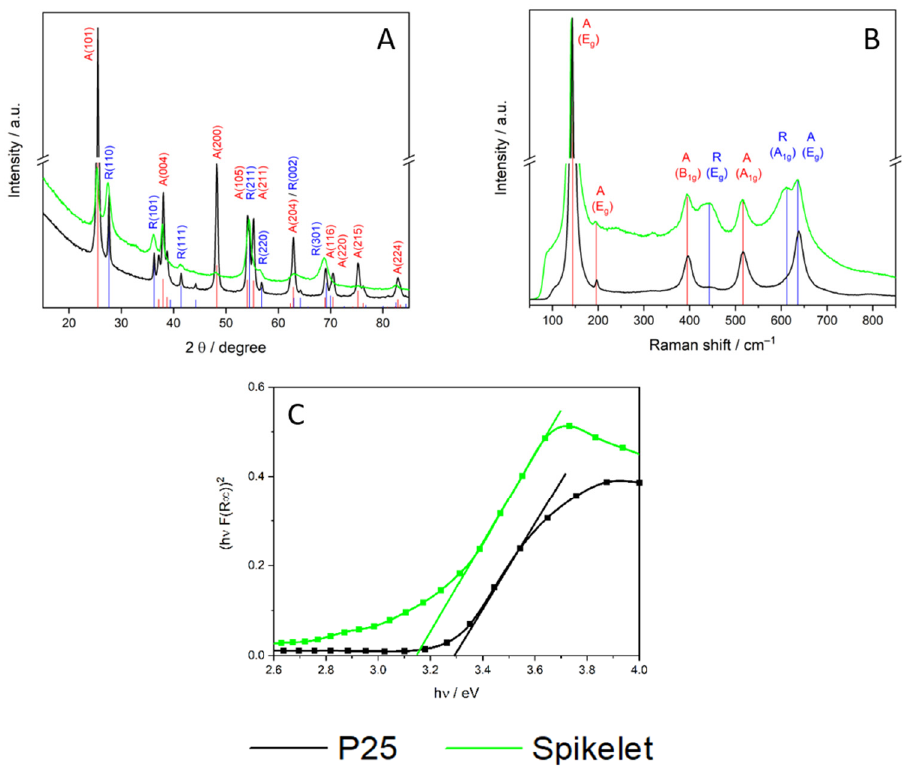
Figure 2. ( A ) Raman spectra, ( B ) XRD pattern and Tauc plot ( C ) of TiO 2 Spikelet layer (green line) and P25 (black).